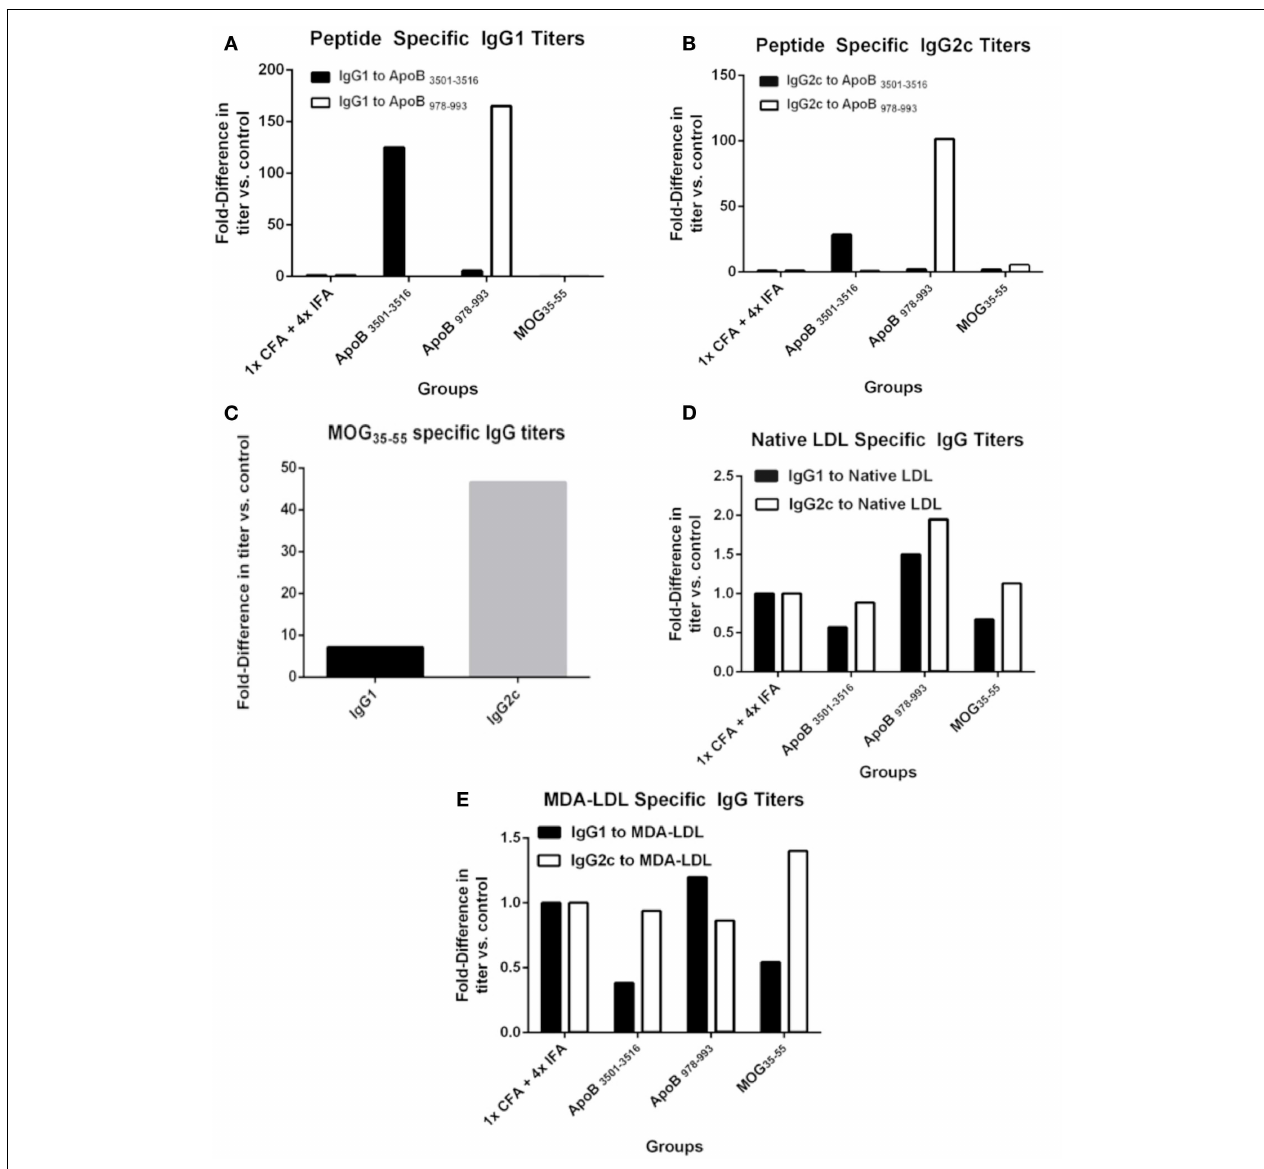
pooled sera from 1 × CFA + 4 × IFA group. (A) IgG1 titers against ApoB 3501–3516 and ApoB 978–993 . (B) IgG2c titers against ApoB 3501–3516 and ApoB and (E) MDA